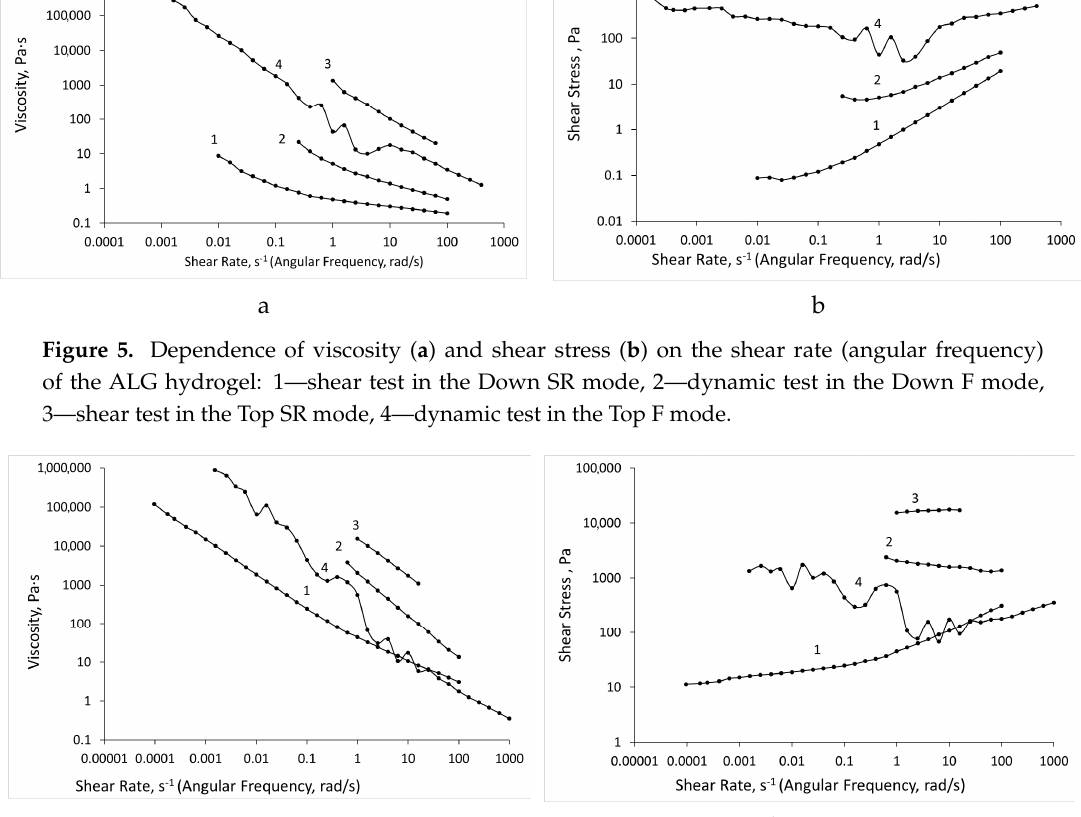
Figure 6. Dependence of viscosity ( a ) and shear stress ( b ) on the shear rate (angular frequency) of the ALG-CNW (7.5%) hydrogel: 1—shear test in the Down SR mode, 2—dynamic test in the Down F mode, 3—shear test in the Top SR mode, 4—dynamic test in the Top F mode. Table 1. Rheological properties of ALG-CNW hydrogels ( η ∞ = 0.0009 Pa · s, p = 0.667).